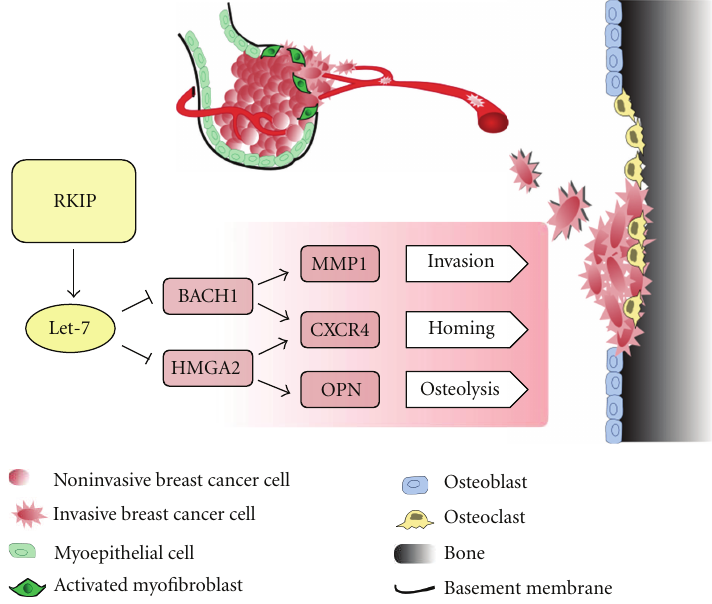
Figure 1: Schematic representation of the RKIP signaling pathway and its e ff ects on metastatic progression to the